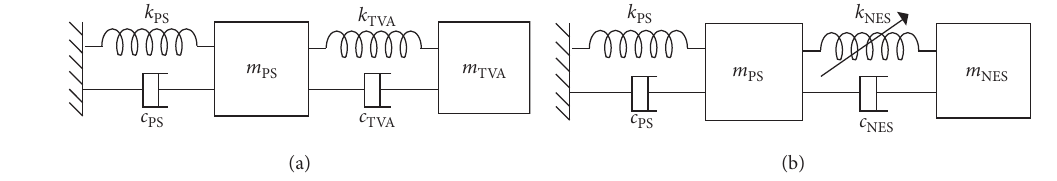
Figure 3: (a) Passive TVA model. (b) Passive NES model.